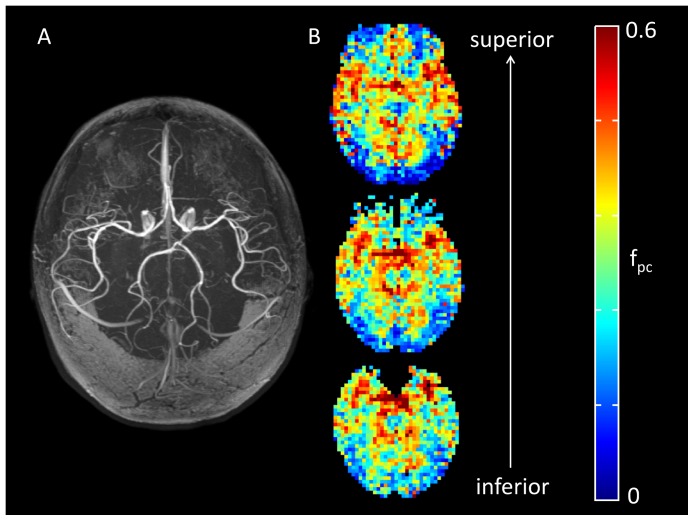
Comparison of time of flight angiography data and two-stage ASL model fitting in a healthy adult.(A) Axial maximum intensity projection from time of flight angiography, showing large arteries such as the anterior, middle, and posterior cerebral arteries. (B) Maps of the fitted fpc parameter (pre-capillary blood volume), derived from ASL data collected in the same subject.